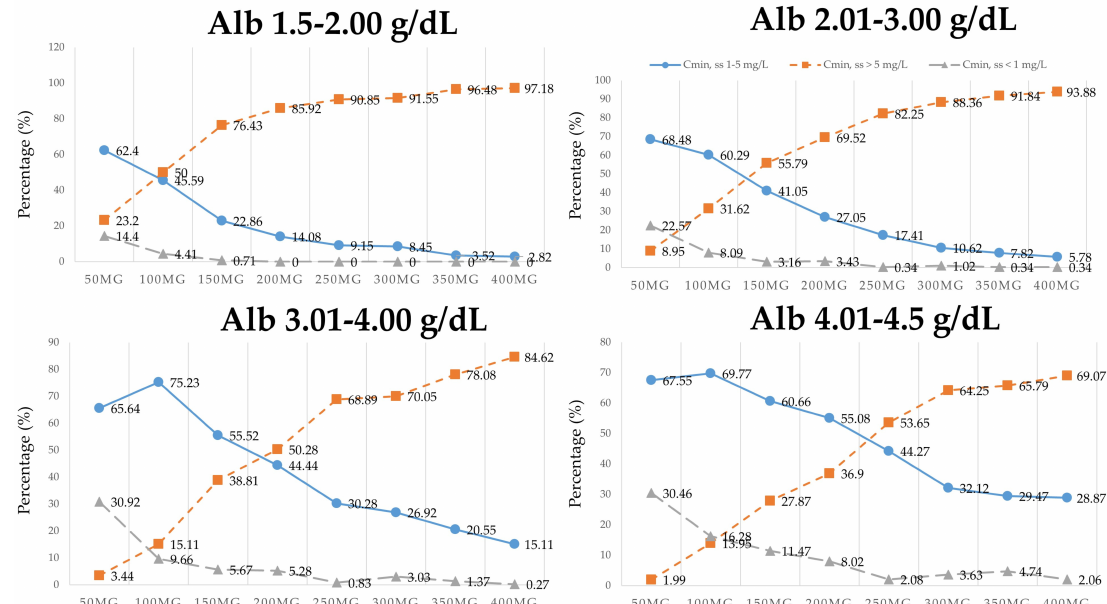
Figure 4. Simulated steady-state trough or minimal concentrations (C min, ss ) in the omeprazole ≥ 40 mg / day group stratified by plasma albumin (Alb) and voriconazole dose administration (50, 100, 150, 200, 250, 300, 350, and 400 mg orally every 12 h of voriconazole). The round, square, and triangle lines show the percentage that achieved a therapeutic range (C min, ss = 1–5 mg / L), a toxic range (C min, ss > 5 mg / L), and a sub-therapeutic range (C < 1 mg / L), min, ss